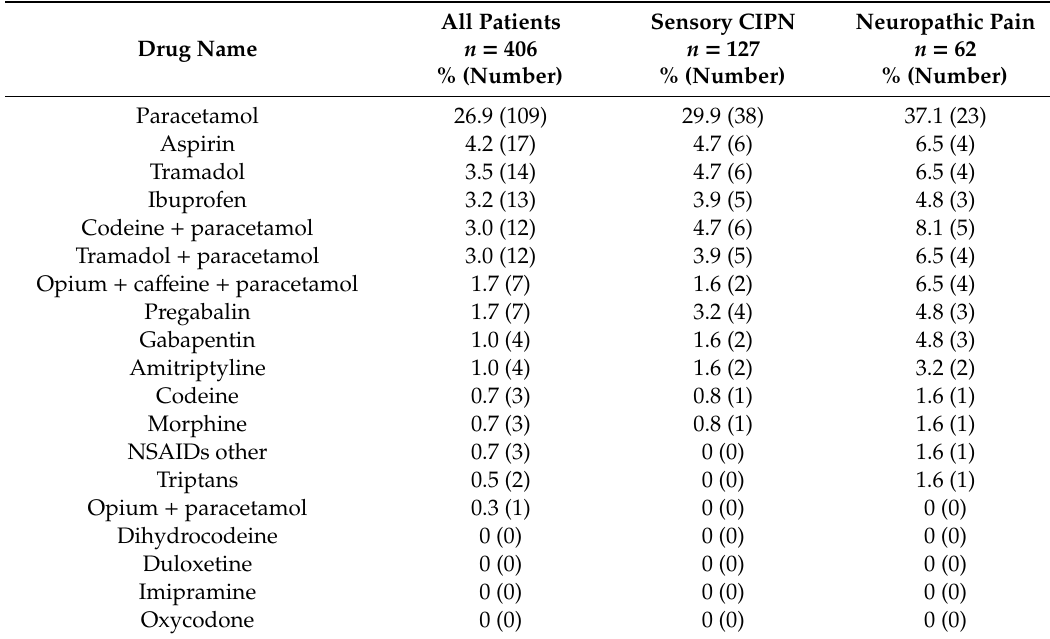
Table 2. Type and proportion of analgesic medication use in the month prior to questionnaire completion for all patients, in patients with sensory CIPN and in those with neuropathic